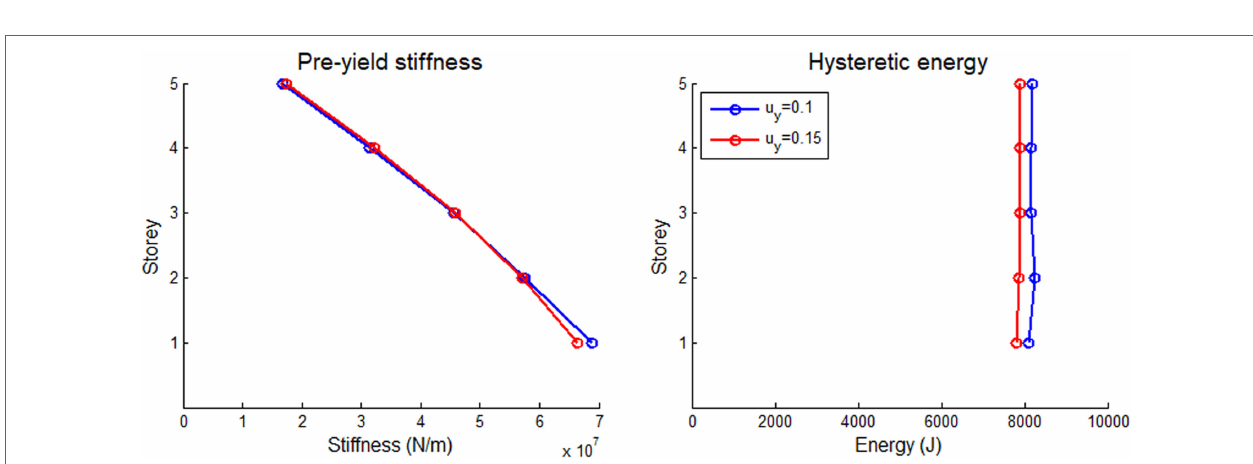
FIGURE 11 | Optimum distributions of elastic pre-yield stiffness and energy dissipated due to hysteresis for the 10-storey shear building with (cid:22) uy = 0.04 subject to the El Centro earthquake record for various critical modal damping ratios.